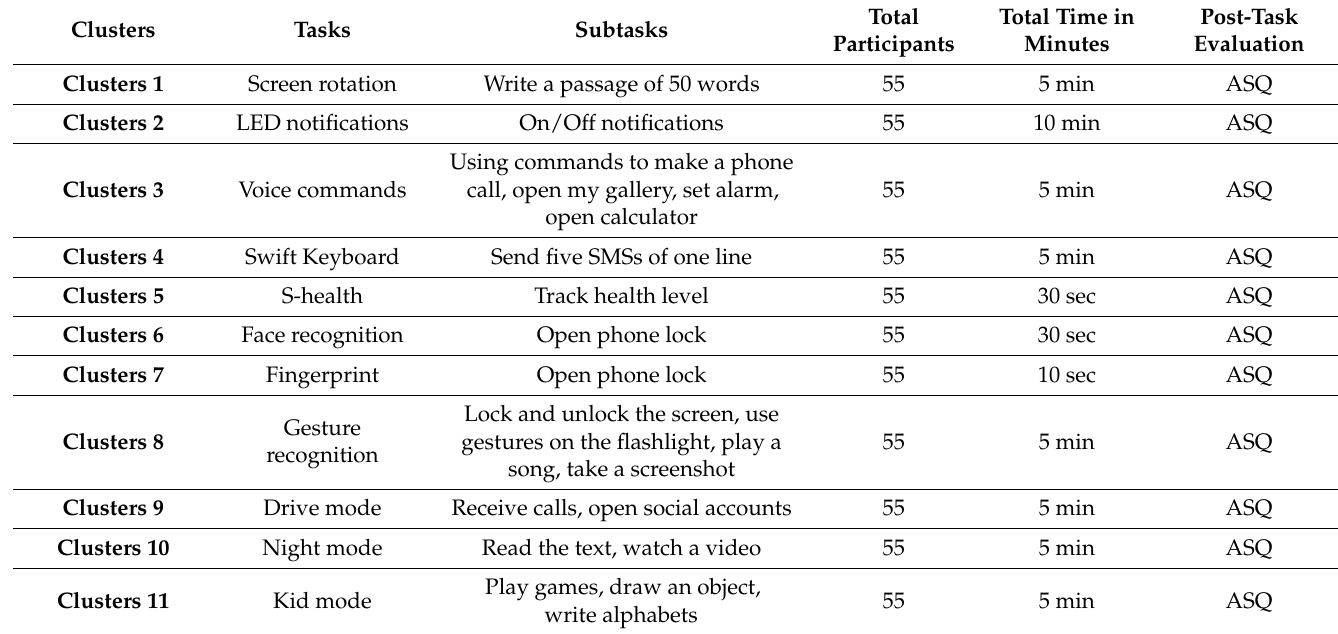
Table 2. Clusters for